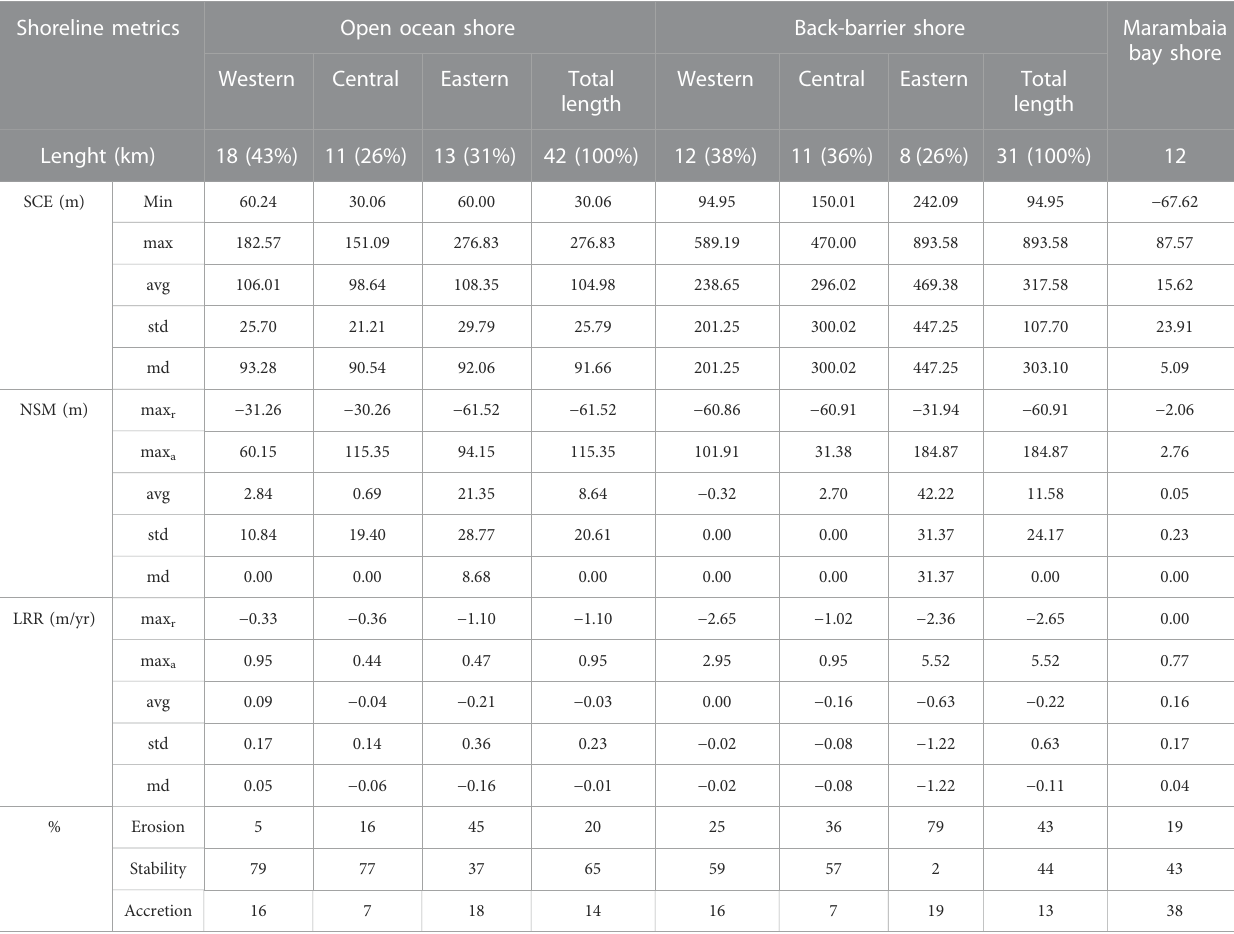
TABLE 1 Statistical parameters of the metrics and rates of barrier island each sector. Shoreline metrics Open ocean